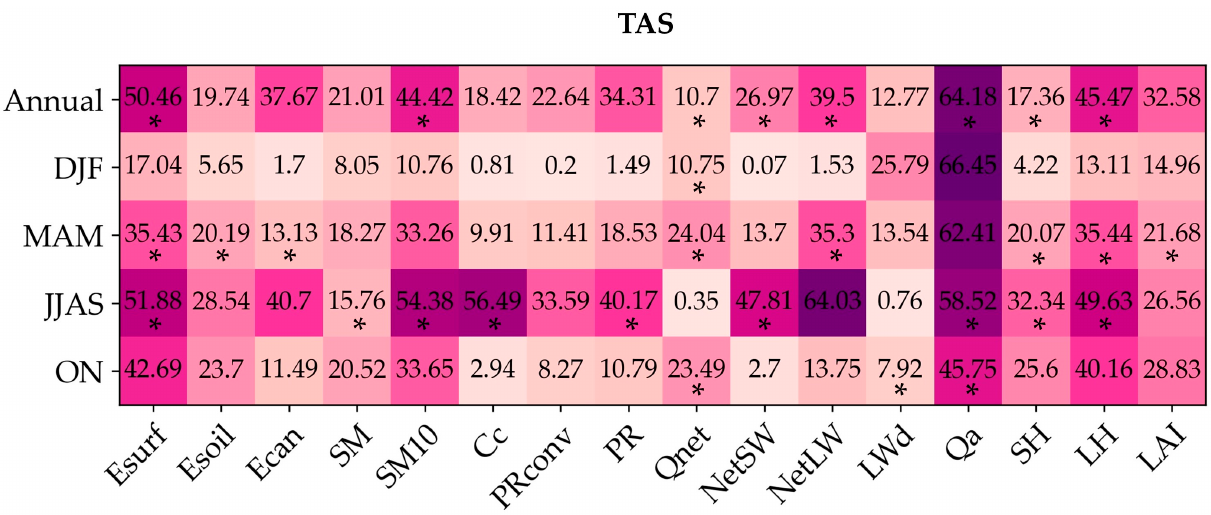
Figure 8. Heatmap with R 2 values of the linear relationships between TAS changes and the fluxes with their associated land surface variables. The strength of the relationship is characterized by the intensity of the shaded color, where darker shades denote stronger R 2 values. Values marked with an asterisk are significant at a 95% confidence